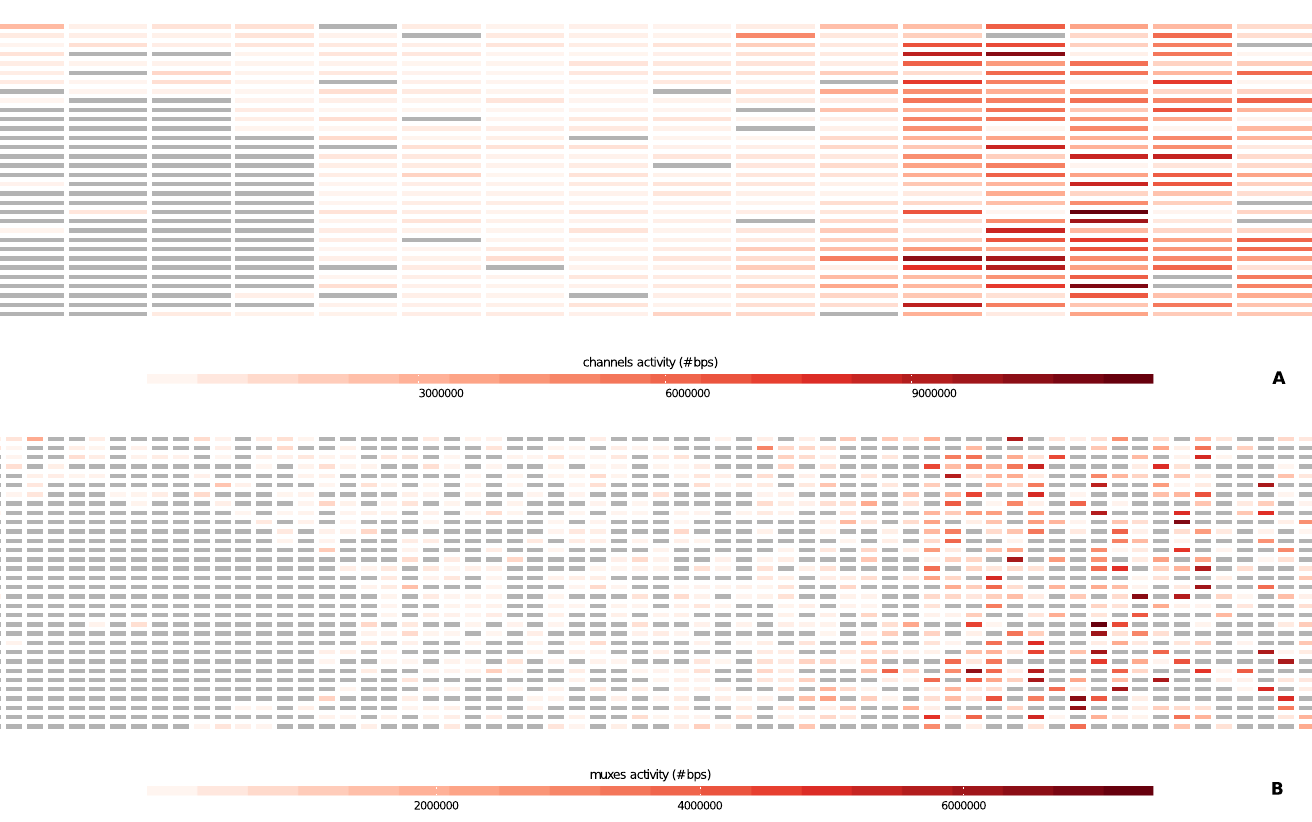
Fig 4. Heatmap of channels and muxes activity. The plots show the base pairs productivity of channels ( Panel A ) and muxes ( Panel B ) with respect to their real disposition on the Flow Cell (as described in https://community.nanoporetech.com/technical_documents/hardware/v/hwtd_5000_v1_revh_03may2016/flow-cell-chip) for a MinION run; inactive channels and muxes are